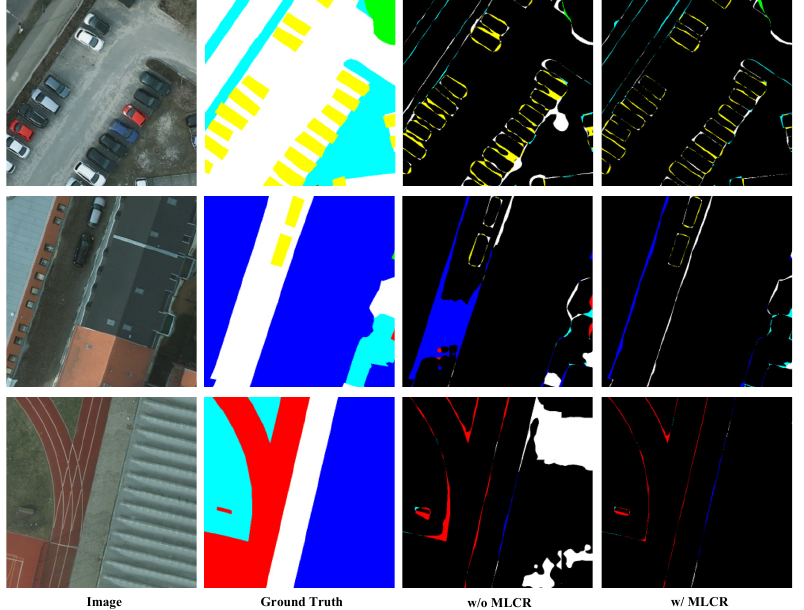
Figure 10. Qualitative comparison in terms of prediction errors on Potsdam test set, where correctly predicted pixels are shown with a black background and incorrectly predicted pixels are colored using the prediction results (best viewed when colored and zoomed in).